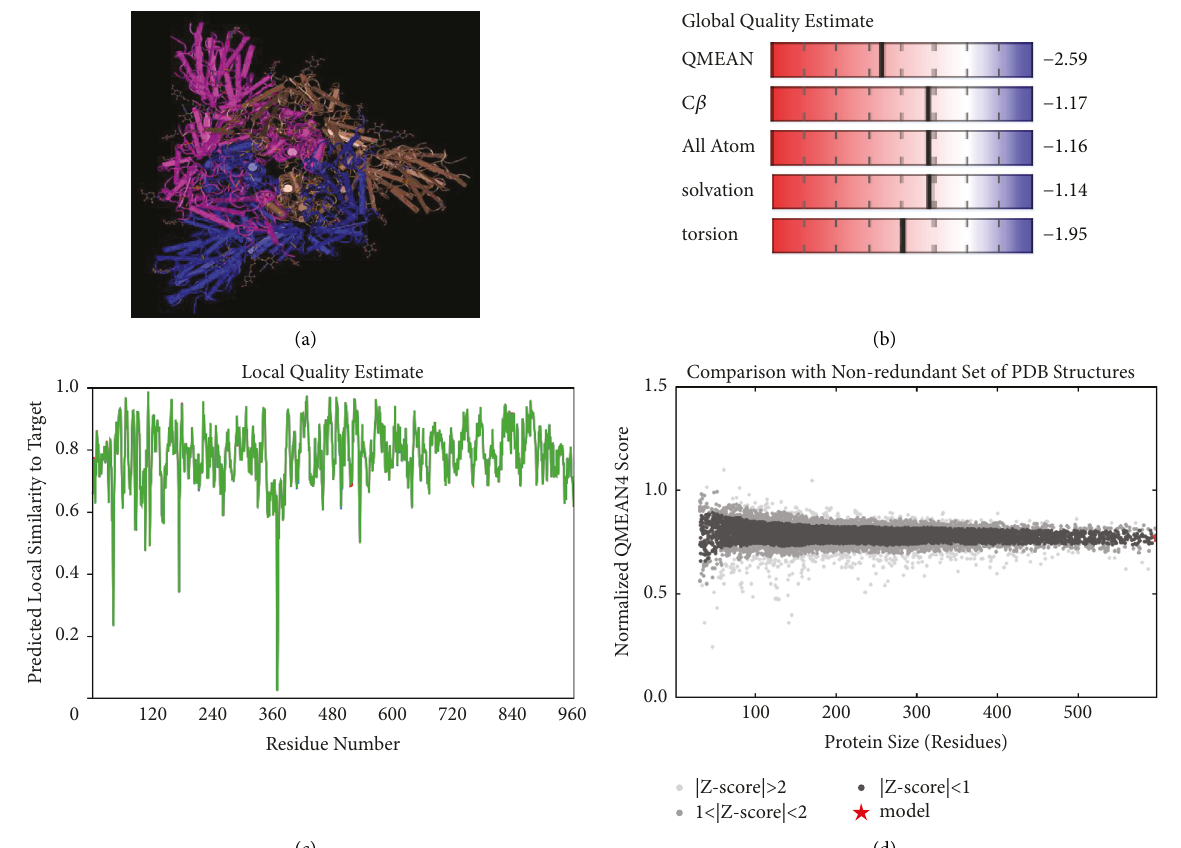
Figure 2: Bioinformatics analysis and computer simulation molecular modeling of SARS-CoV-2-SG. (a) Three-dimensional structures, (b) QMEAN value, (c) local model quality overall model quality, and (d) comparison with a nonredundant set of SARS-CoV-2-SG